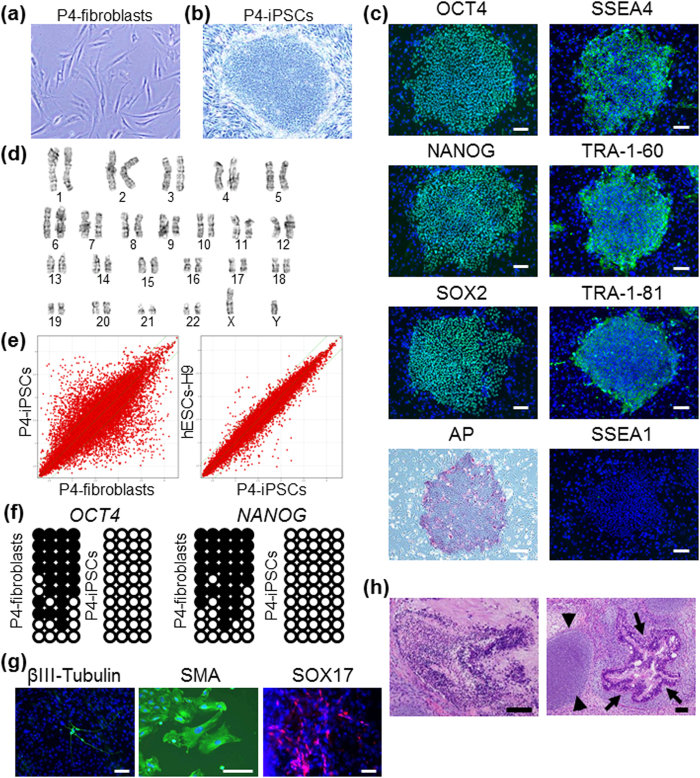
Derivation of Patient-specific iPSCs from ADPKD Patients.ADPKD patient’s (P4) fibroblasts (a) were converted into ADPKD-iPSCs (b) after retroviral transduction with OCT4, SOX2, KLF4 and c-MYC. (c) The expression of pluripotency markers, such as OCT4, NANOG, SOX2, SSEA4, TRA-1-60 and TRA-1-81, and alkaline phosphatase (AP) enzymatic activities in P4-iPSCs. Note that a mouse pluripotency marker SSEA1 is negative. (d) The normal karyotype of P4-iPSCs (46, XY [20]). (e) The global gene expression patterns were compared between P4-iPSCs and P4-fibroblasts, and between P4-iPSCs and human ESCs (H9) using microarray analyses. (f) A bisulfite sequencing analysis of the OCT4 and NANOG promoters in P4-fibroblasts and P4-iPSCs. (g) After 16 days of differentiation with embryoid body (EB) formation, cells were stained with anti-βIII-tubulin (ectoderm), SMA (mesoderm) and SOX17 (endoderm) antibodies. (h) Teratomas were generated by injecting P4-iPSCs into the testes of immunocompromised NOD-SCID mice. Neural tissue (ectoderm; left panel), cartilage tissue (mesoderm; right, arrowheads) and intestinal epithelia (endoderm; right, arrows) were observed. Scale bars, 100 μm. See also Figures S1–S6, Tables 1, S1 and S2.